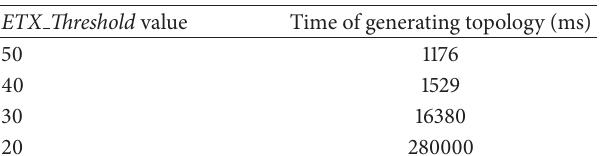
Table 1: Time of generating topology with different ETX Threshold values.